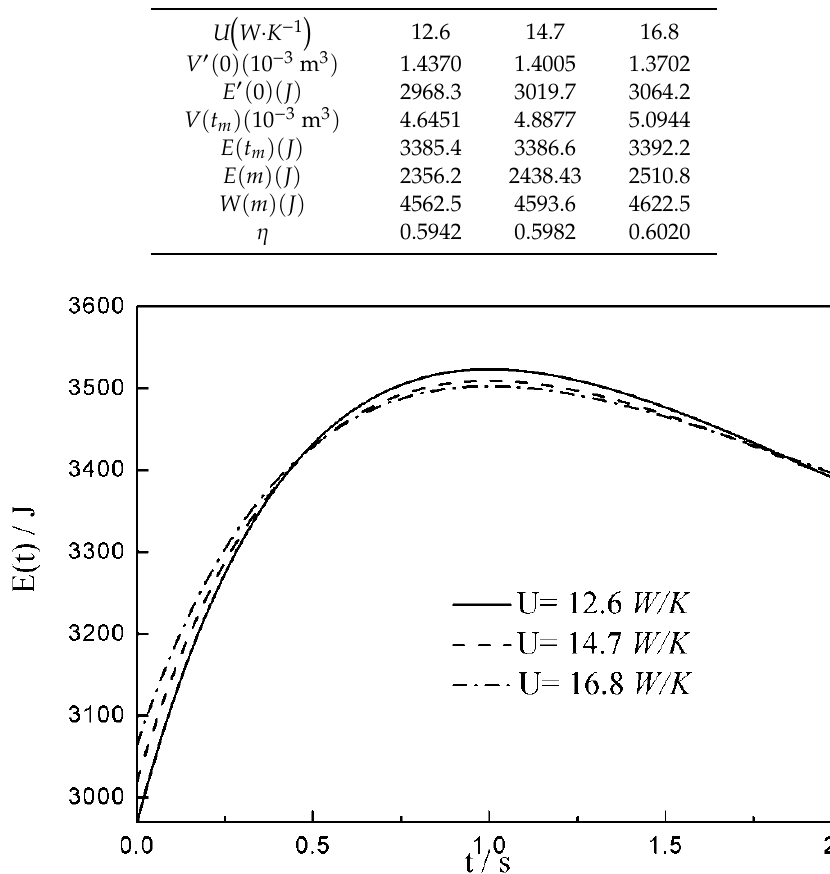
Figure 3. Optimal volume versus time as n = 1.